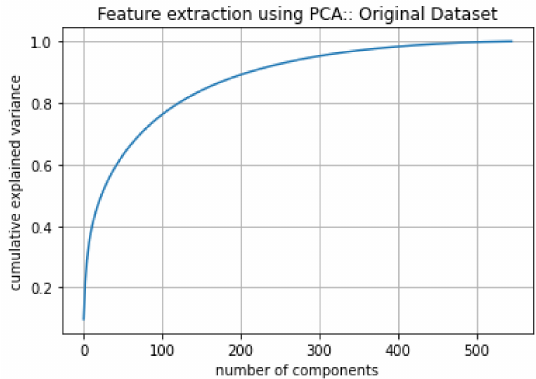
Figure 7. PCA analysis on original dataset.